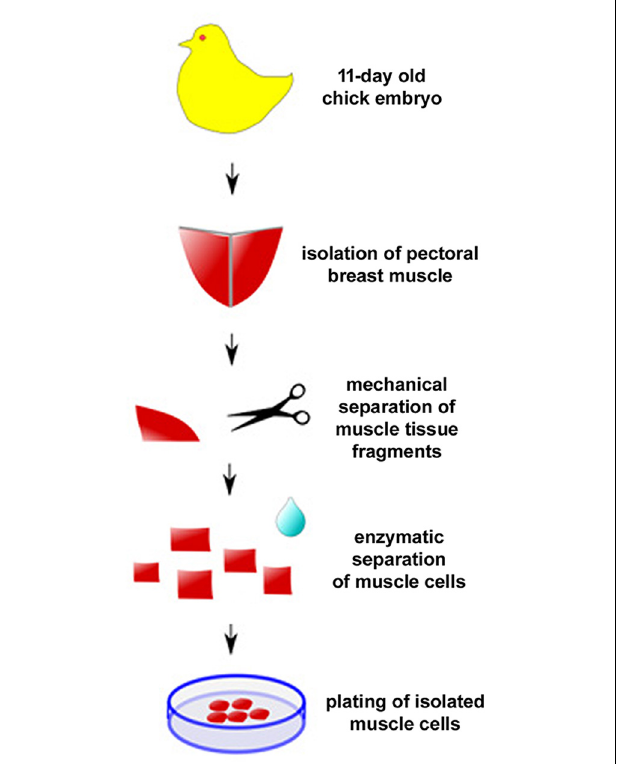
FIGURE 4 | Protocol for primary culture of embryonic chick myogenic cells. Schematic representation of the main steps involved in the culture of embryonic chick pectoral breast muscle